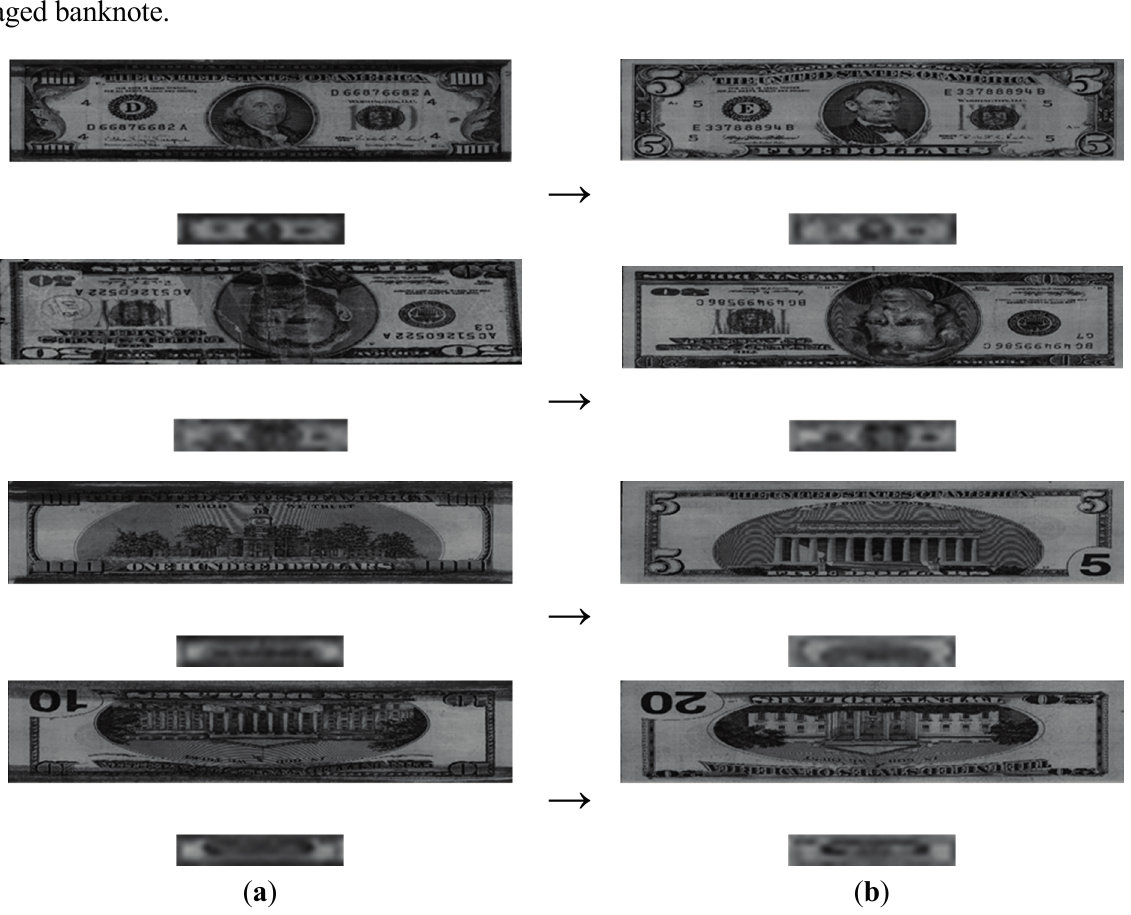
Figure 11. Cases of incorrect banknote recognition: ( a ) input images; ( b ) falsely recognized